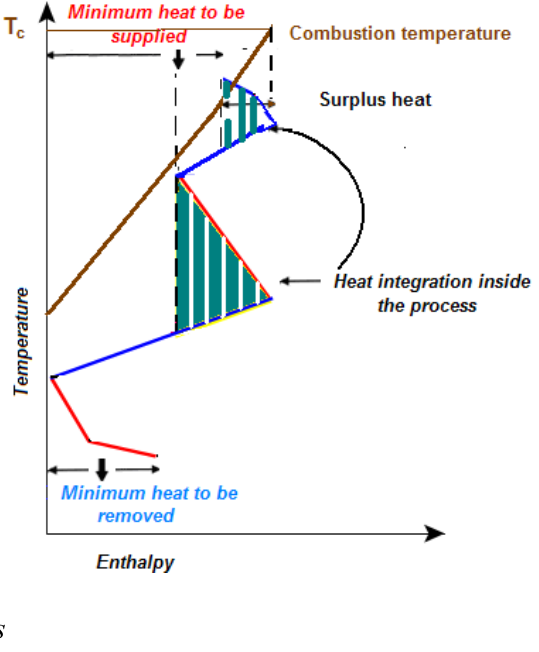
Figure 7. D etermination of available heat when heat is supplied from fuel